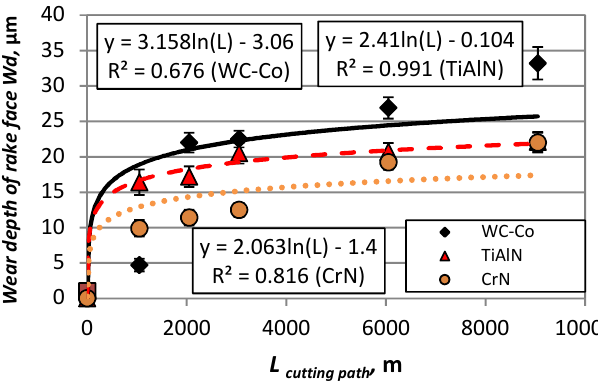
Figure 9. Influence of the cutting path L on the wear of the rake surface of the hard metal WC-Co cutter with and without PVD coatings when a milling speed of 17 m·s −1 is applied on the cutting plane.